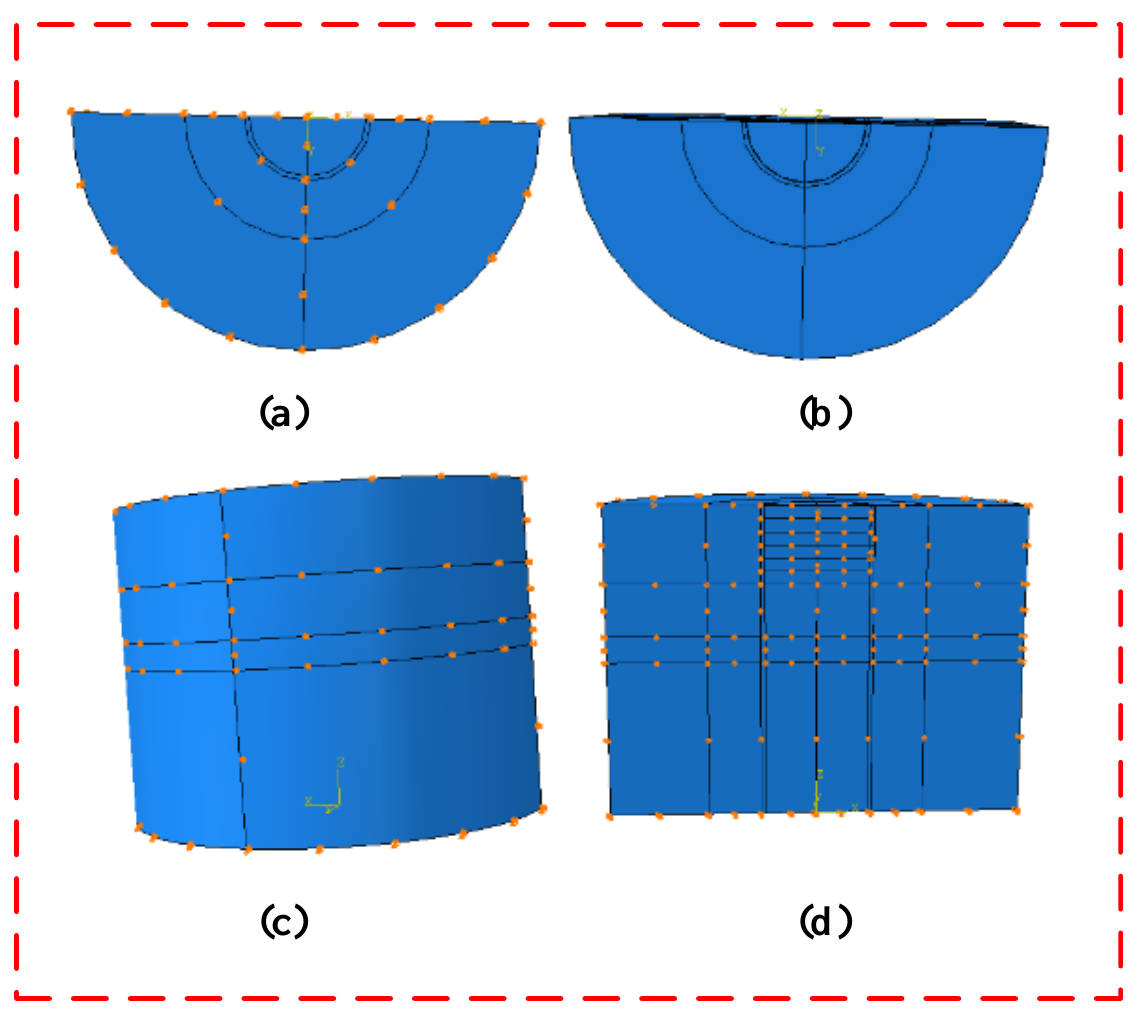
Figure 8. Schematic diagram of model constraints: ( a ) model bottom constraints; ( b ) model top constraints; ( c ) model side constraints; ( d ) model frontal constraints.